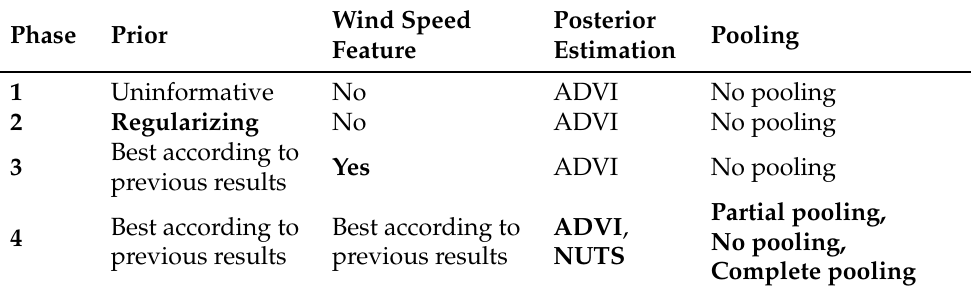
Table 1. Model comparison